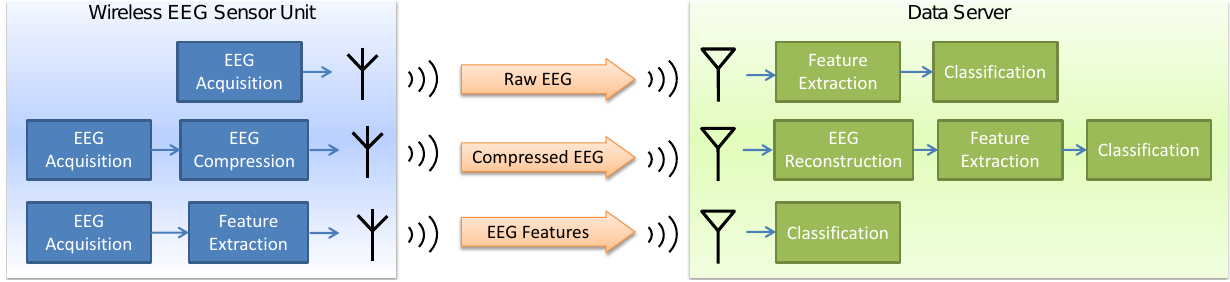
Figure 1. Transmission of electroencephalogram (EEG) in a wireless seizure detection system. ( Top ) The entire EEG signals are transmitted. ( Middle ) The EEG signals are compressed and transmitted. ( Bottom ) Features that are pertinent to seizure detection are extracted from the EEG signals and